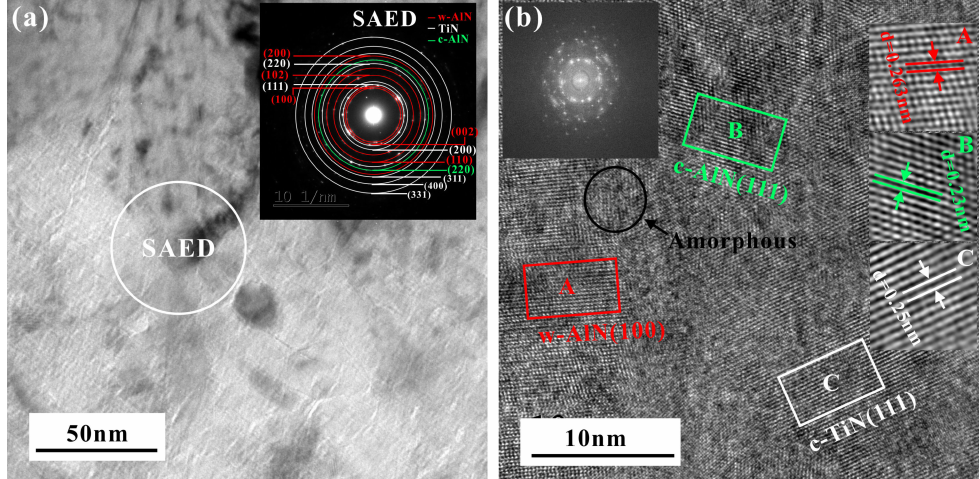
Figure 5. Cross-sectional TEM images of CVD Ti 0.13 Al 0.85 Si 0.02 N coating. ( a ) A bright field TEM image with an SAED pattern in the inset and ( b ) HRTEM image and FFT pattern of the